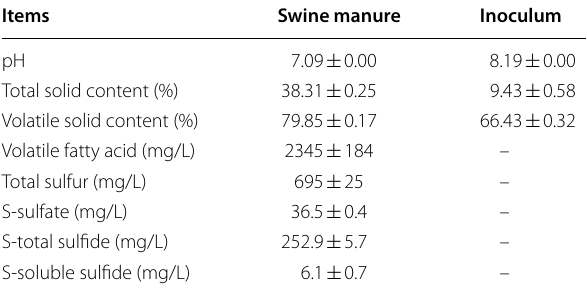
Table 1 Basic characteristics of pig manure and inoculum used in the present